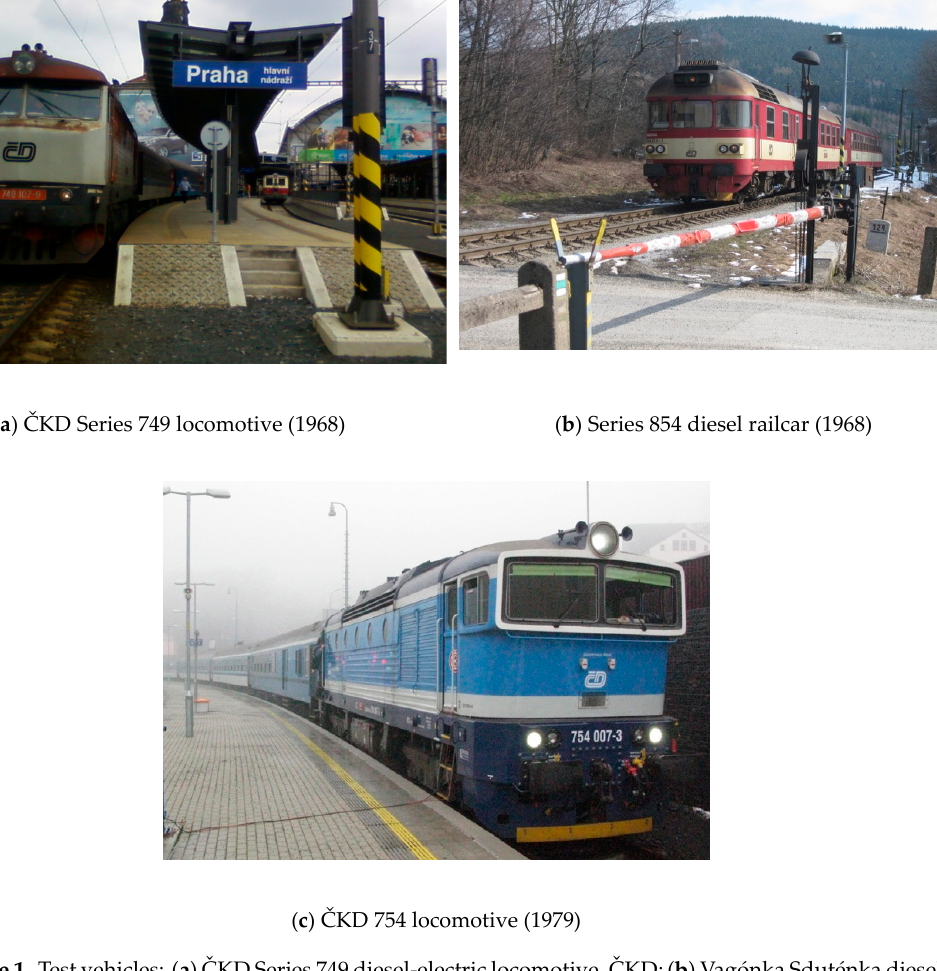
Figure 1. Test vehicles: ( a ) Č KD Series 749 diesel-electric locomotive, Č KD; ( b ) Vagónka Sduténka diesel railcar series 854 with hydraulic power transmission; and ( c ) Č KD 754 Series